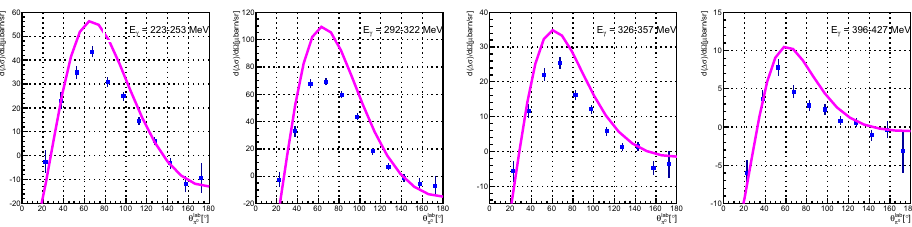
Figure 2. Helicity dependent di ff erential cross section for the semi-exclusive channel A2 results (blue circles) are compared to the sum of MAID for free proton and neutron (dashed magenta line).